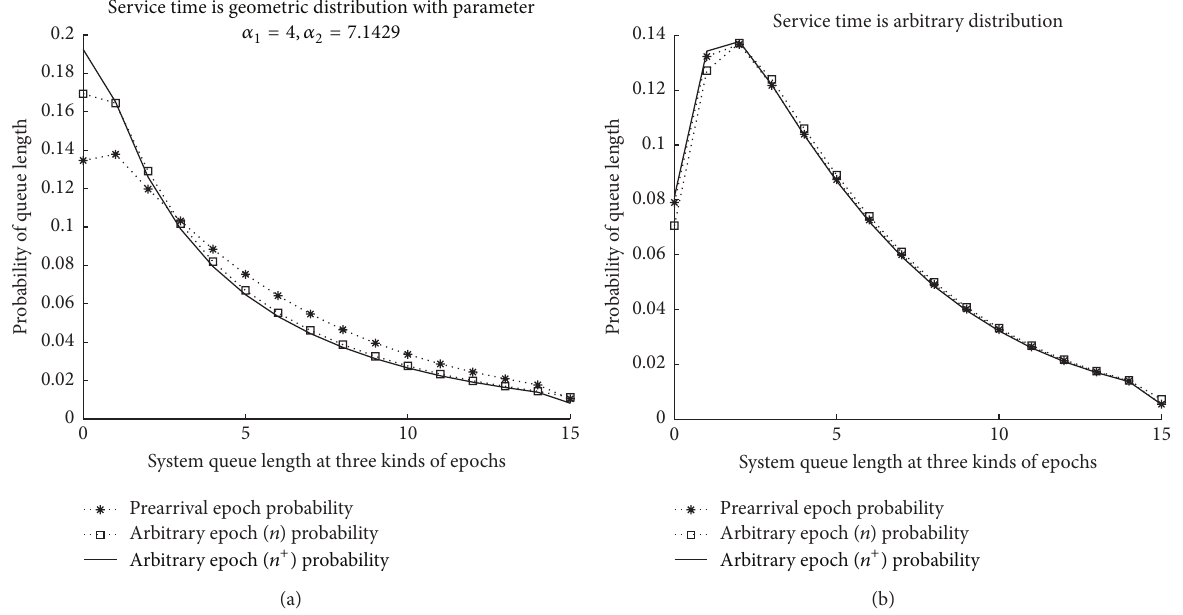
Figure 2: (a) Steady queue length distributions at different epochs. (b) Steady queue length distributions at different epochs.